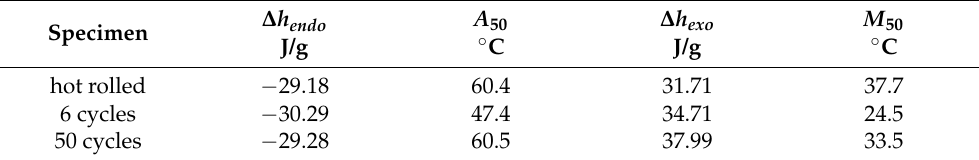
Table 3. Variations of specific absorbed ( ∆ h endo ) and released ( ∆ h exo ) enthalpies and temperatures of reverse ( A 50 ) and direct ( M 50 ) transformation peaks with the number of WG-SME training cycles according to Figure 6.